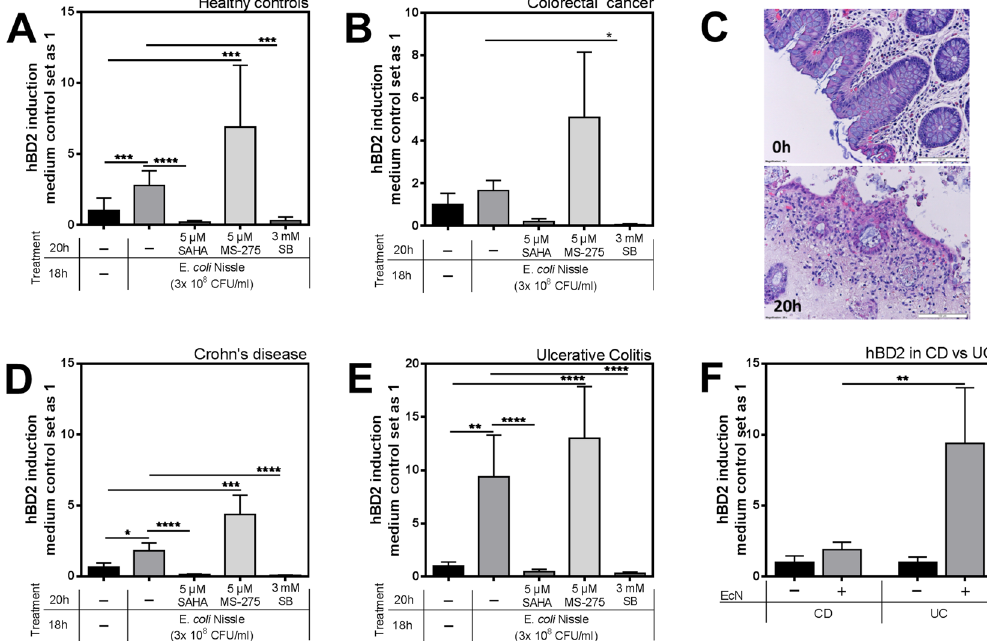
Figure 5. Inhibition of histone deacetylases (HDACs) hinders human β -defensin 2 (hBD2) induction in human colonic biopsies. HBD2 mRNA expression in cultured human colonic biopsies of ( A ) 13 healthy controls and ( B ) four colorectal tumor specimens in response to EcN, alone or together with either SAHA (5 µ M), MS-275 (5 µ M), or SB (3 mM). Inhibitor treatment started 2 hrs prior to the stimulation with EcN, which took then place in parallel to HDAC inhibition for another 18 hrs. ( C ) Hematoxylin and eosin staining of an uncultured (0 h) and medium cultured (20 h) healthy control biopsy. ( D ) HBD2 mRNA expression in colonic biopsies of 29 patients with Crohn’s Disease (CD) or 14 patients with ulcerative colitis (UC) ( E ). ( F ) Direct comparison of the hBD2 fold inductions in both disease entities CD or UC after EcN stimulation. Shown are relative fold changes compared to medium treatment alone according to 10 ng total RNA normalized to β actin expression. * p < 0.05,